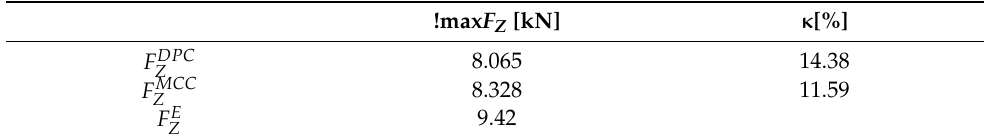
Table 4. The maximum F z